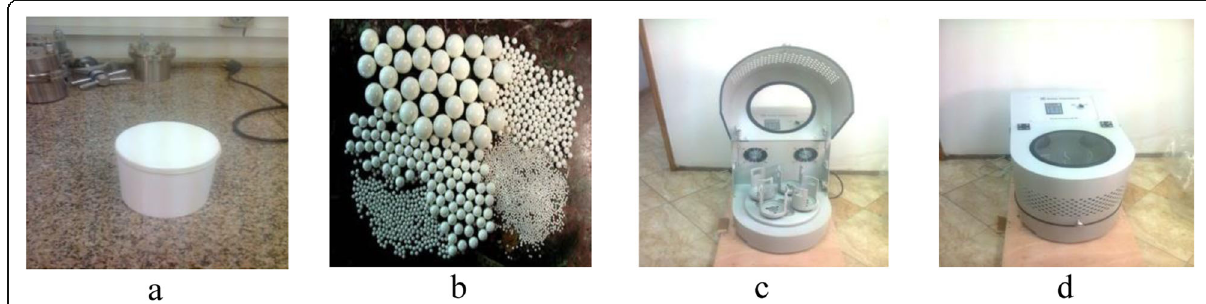
Fig. 1 PM 100 Planetary Ball-mill parts: bowl ( a ), balls ( b ), bowl ’ s tray ( c ), and complete closed unit ( d